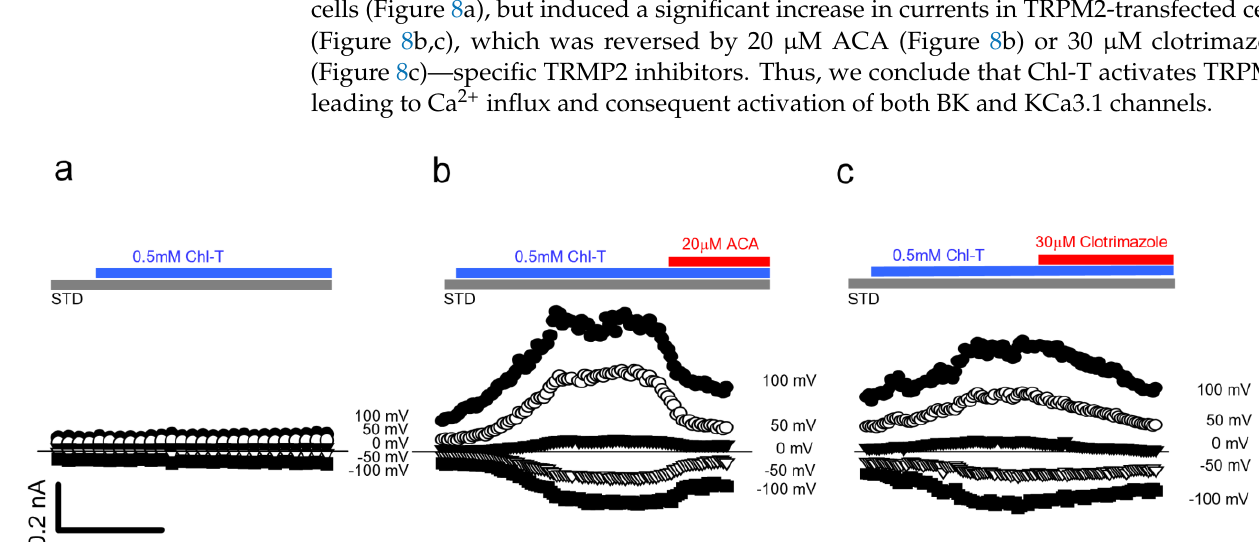
Figure 8. Activation of heterologously expressed TRMP2 by Chl-T. ( a ) Time course of currents elicited in an HEK-null cell during the addition of 0.5 mM ChlT in STD solution. ( b , c ) Time course of currents recorded in two representative transfected HEK293 cells during the application of 0.5 mM ChlT and subsequent addition of 20 µ M ACA ( b ) or 30 µ M clotrimazole ( c ). Normalized current increase at 100 mV: 2.18 ± 0.39, p = 0.007, n = 11. Average ACA block at 100 mV: 55.89 ± 1.92% ( p = 0.00006, n = 4), and average clotrimazole block at 100 mV: 29.48 ± 1.97 ( p = 0.0007, n = 4).